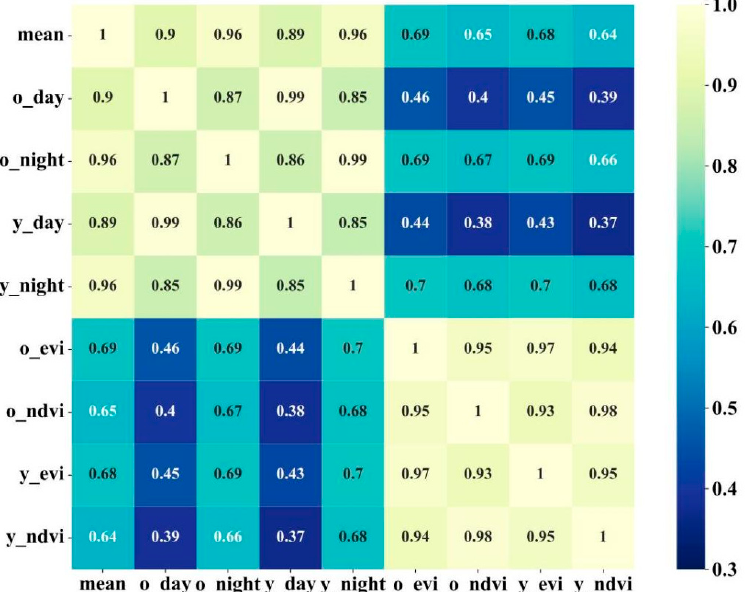
Figure 2. Data correlation heat map between mean NLSAT and considered environment factors . Table 2. Main data sources and their use in this study.